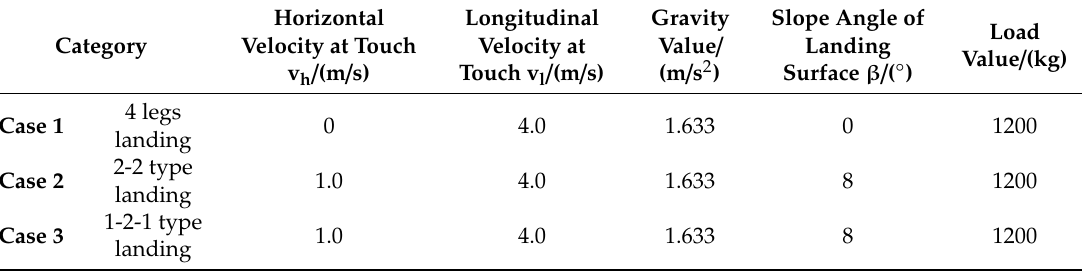
Table 8. Load case property and initial condition of ML